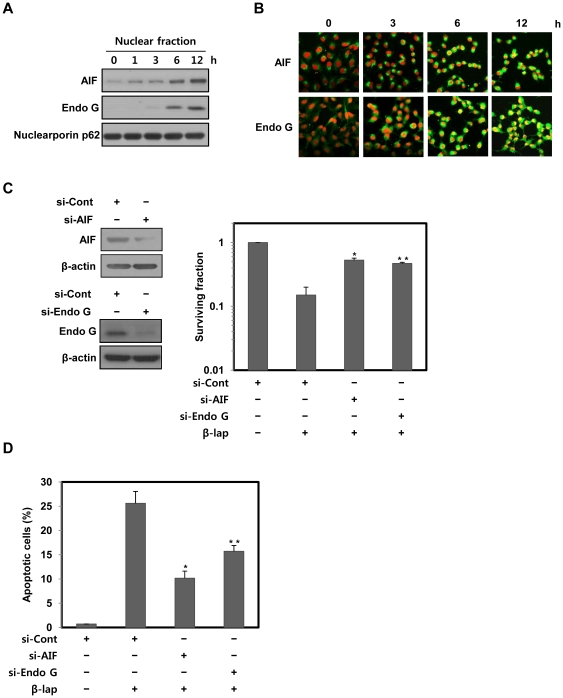
β-lap induces cell death in AIF and Endo G-dependent manners.(A) Nuclear fractions were obtained from NQO1+-MDA-MB-231 cells treated with 5 µM of β-lap for the indicated times, and were subjected to Western blot analysis using anti-AIF, -Endo G, and -Nucleoporin p62 antibodies. Nucleoporin p62 was used as a nuclear marker protein. The data are representative a typical experiment conducted three times. The data are representative of a typical experiment conducted three times with similar results. (B) Representative confocal images showing translocation of AIF and Endo G to the nucleus, and nuclear condensation, at the indicated times after treatment with 5 µM of β-lap. Nuclear translocation of AIF and Endo G is demonstrated by overlap of AIF or Endo G (green) and nuclear staining (red), resulting in a yellow color. The data are representative of a typical experiment conducted three times. (C) NQO1+-MDA-MB-231 cells transfected with AIF or Endo G siRNA were treated with 5 µM of β-lap. Cells were allowed to grow for 10 to 14 days and were stained with 0.5% crystal violet and scored for colony formation. Results from three independent experiments are expressed as means ± SEM. *Significant difference between si-cont RNA- and si-AIF RNA-transfected cells after β-lap treatment, at p<0.05. **Significant difference between si-cont RNA- and si-Endo G RNA-transfected cells after β-lap treatment, at p<0.05. (D) NQO1+-MDA-MB-231 cells transfected with AIF or Endo G siRNA were treated with 5 µM of β-lap for 18 h. Cells were stained with PI and the percentage of cells with a sub-G1 DNA content was measured via flow cytometric analysis. Results from three independent experiments are expressed as the means ± SEM. *Significant difference between si-cont RNA- and si-AIF RNA-transfected cells after β-lap treatment, at p<0.05. **Significant difference between si-cont RNA- and si-Endo G RNA-transfected cells after β-lap treatment, at p<0.05.